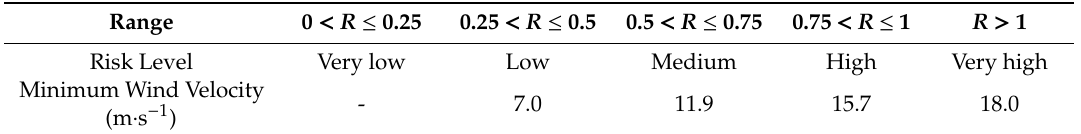
Table 2 Wind risk scale ( R , Equation 13) for rail transport and the minimum wind velocity at vehicle center height associated with each class.